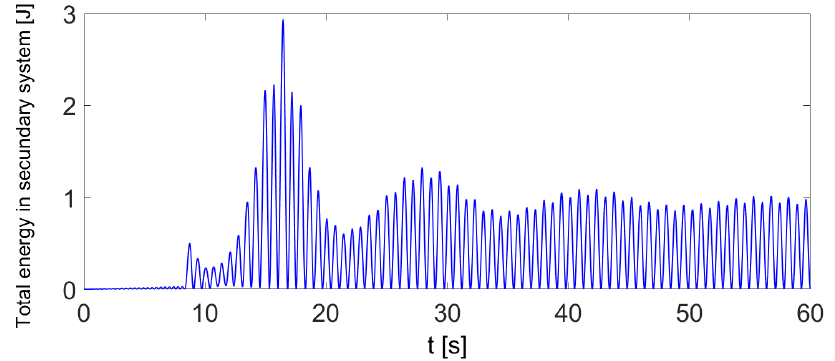
Figure 15. Graph of the total energy in the autoparametric pendulum